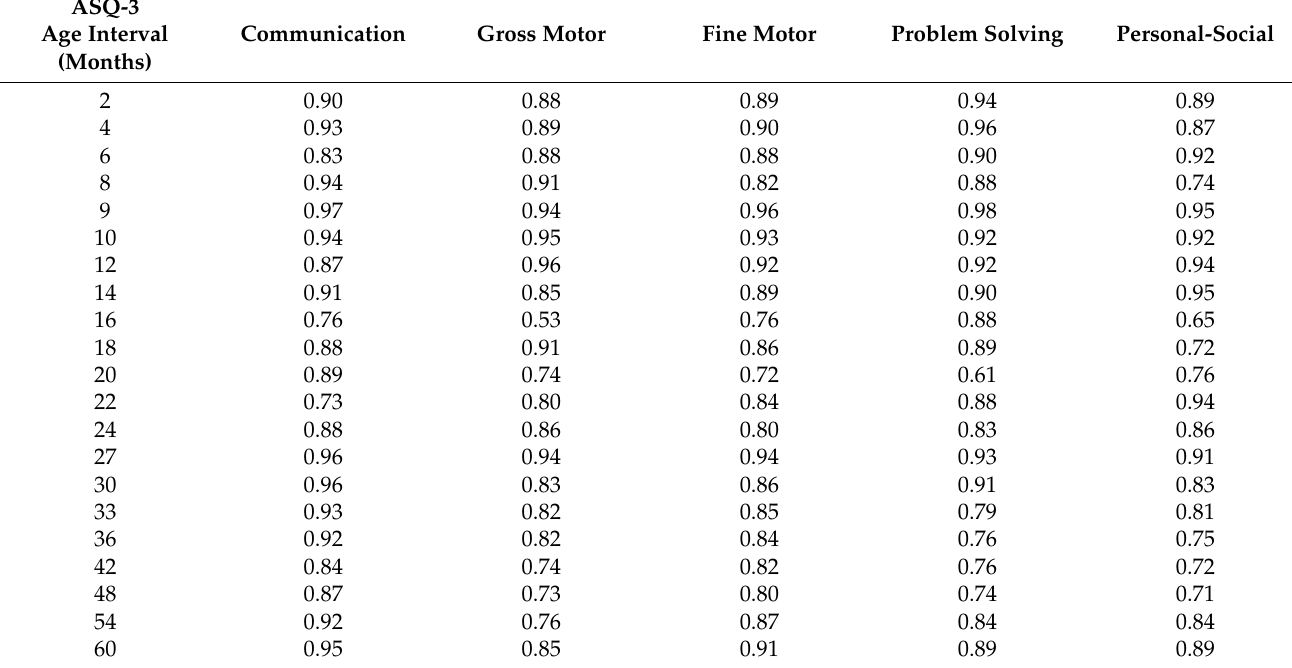
Table 3. Cronbach’s alpha coefficient of ASQ-3 developmental areas.